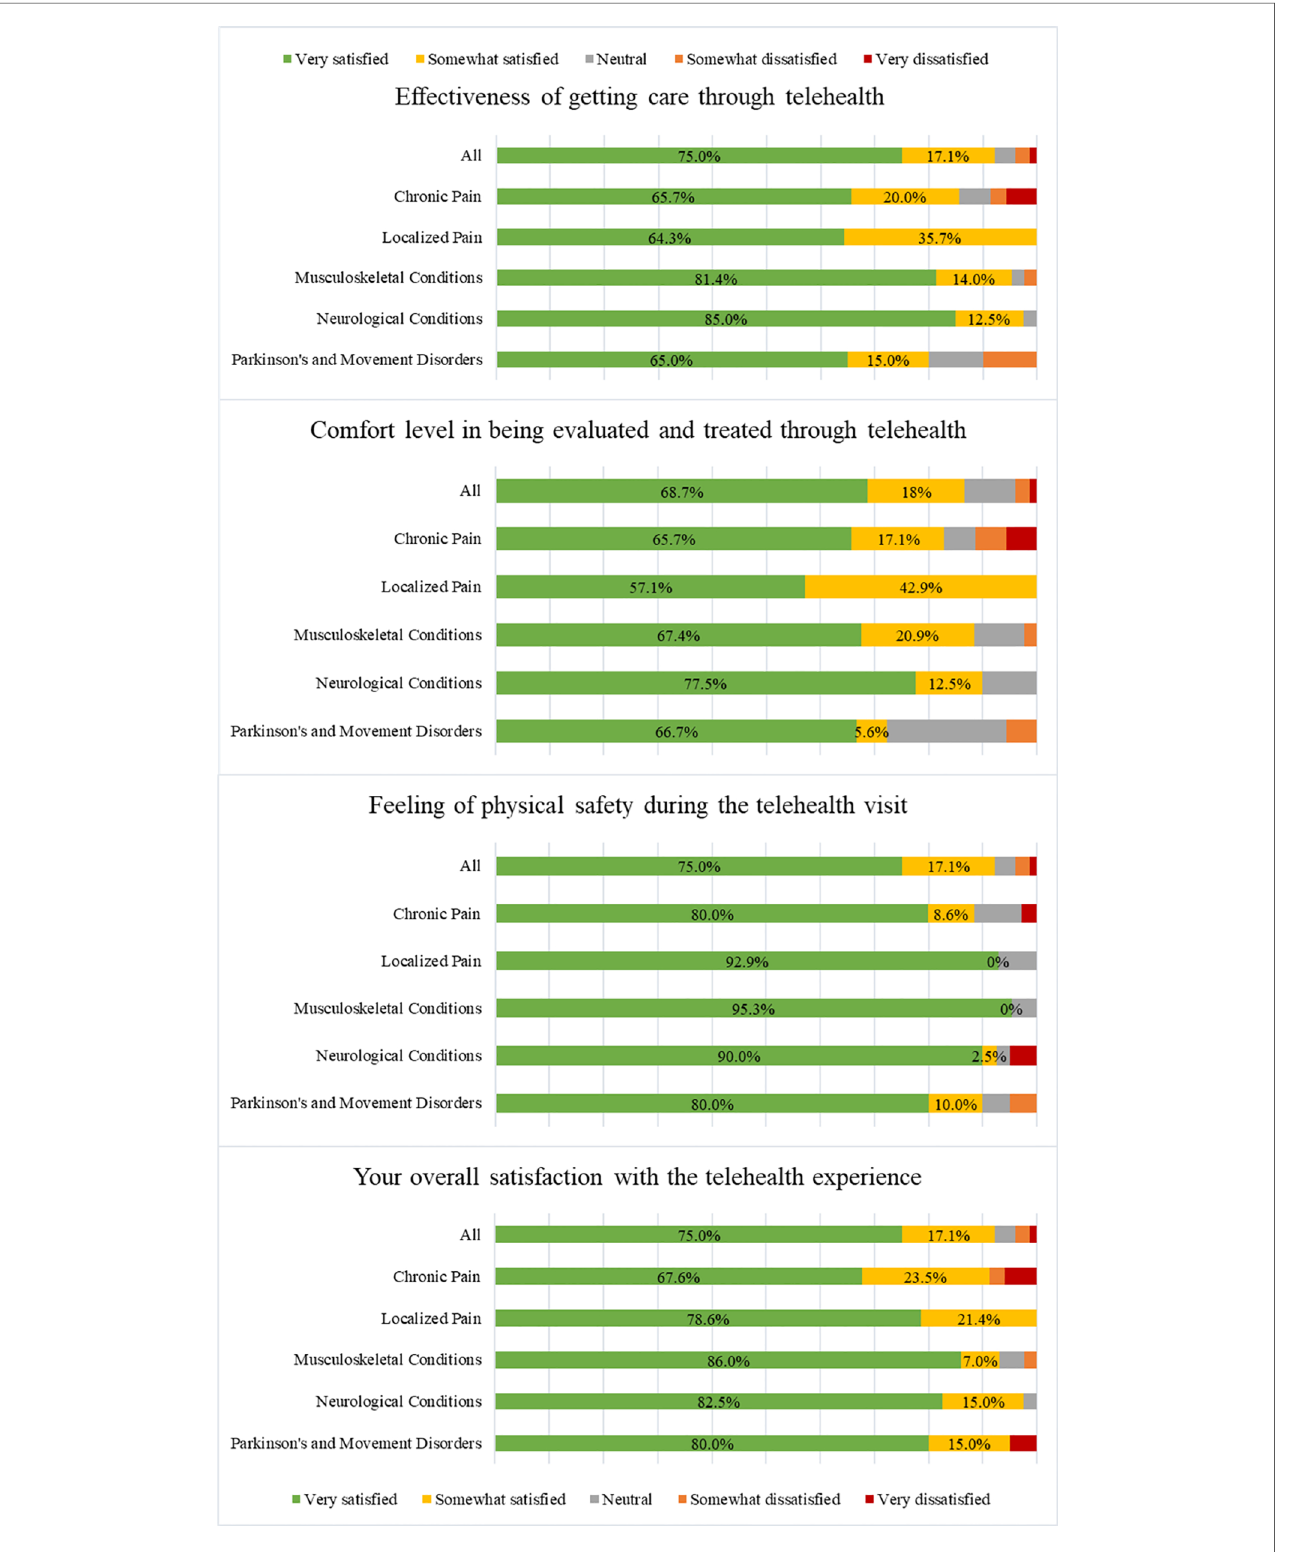
FIGURE 4 Experience, satisfaction, and effectiveness of telehealth by diagnostic